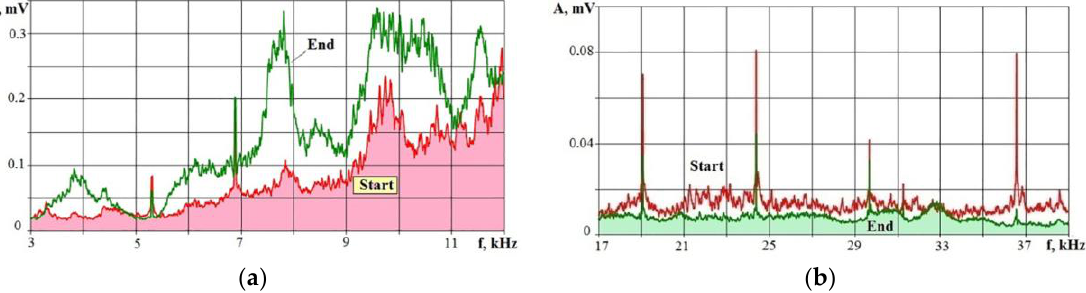
Figure 23. Time recording of VA signals in different frequency ranges in IN23 ceramics die-piercing: ( a ) time recording of signals with amplitudes A 1 and A 2 ; ( b ) change in time of the RMS amplitudes A 1 and A 2 and parameter K f , obtained by dividing the record into 7 intervals.